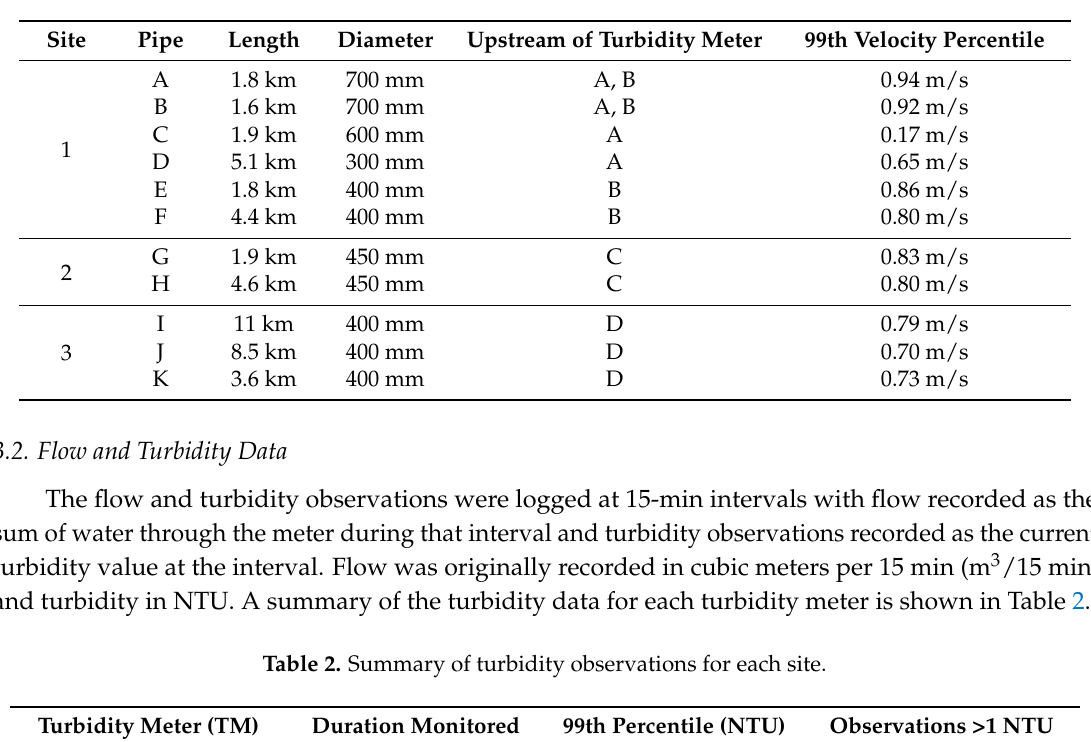
Table 1. Pipe characteristics and the 99th velocity percentile over all observed data for each site.